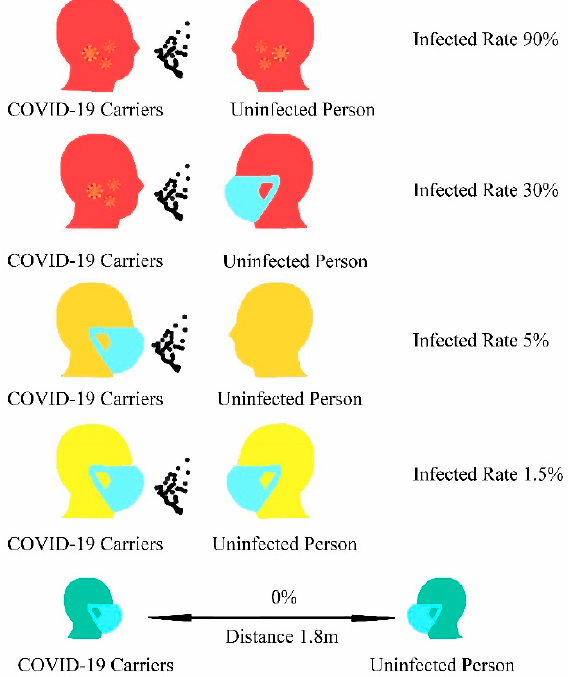
Figure 6. The infection rate when healthy people come into contact with COVID-19 carriers.